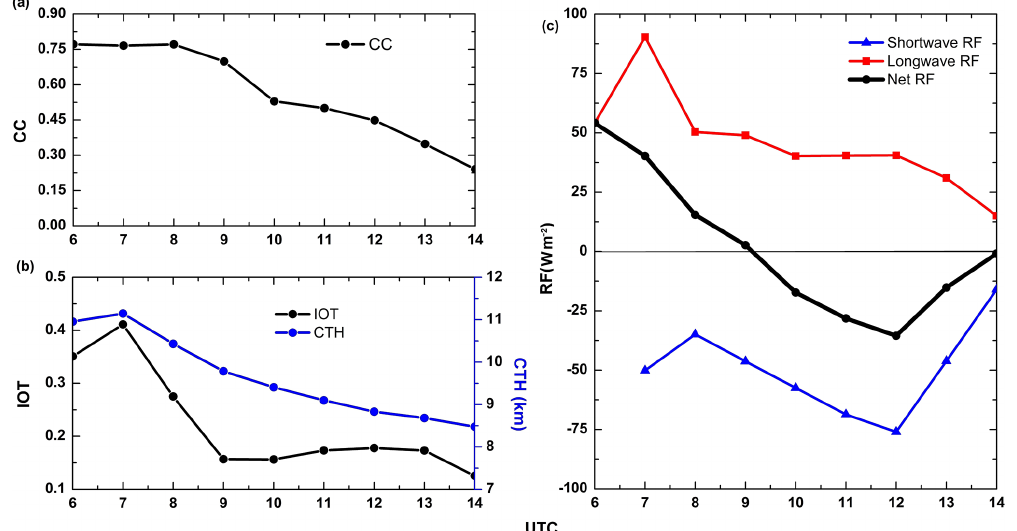
Figure 7. The variations of (a) CC, (b) mean IOT and mean CTH, and (c) SW, LW and net RF within the area indicated by a red box in Fig.